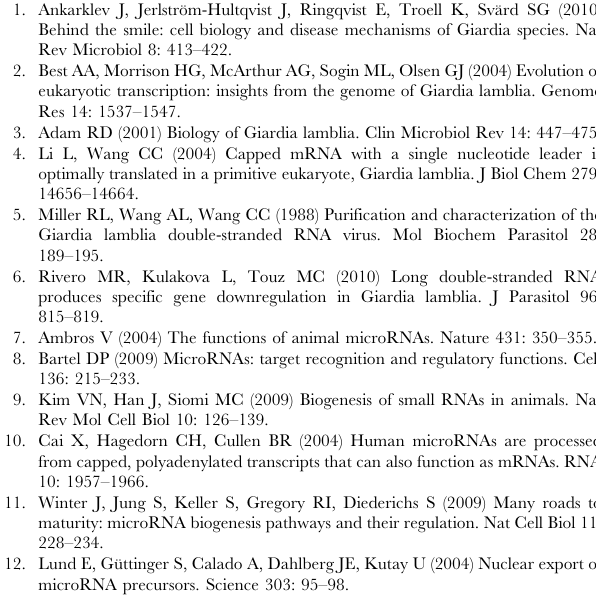
Figure S1 Northern blot assays for RL and RL-TS mRNA from Giardia indicate that the presence of miR5 does not affect the level of RL-TS mRNA. Quantification of the Northern results at the bottom was each derived from three independent transfections. The 16S rRNA was blotted as a loading control. Table S1 Predicted miR5 targeting sites in the Giardia genome using miRanda